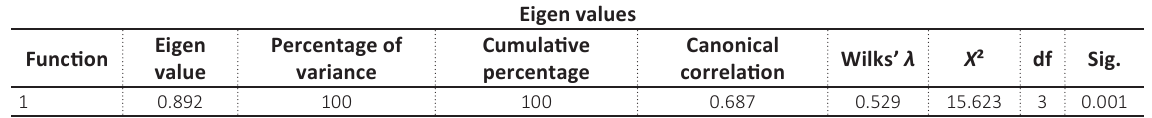
Table 13. Outline of canonical discriminant functions ( t